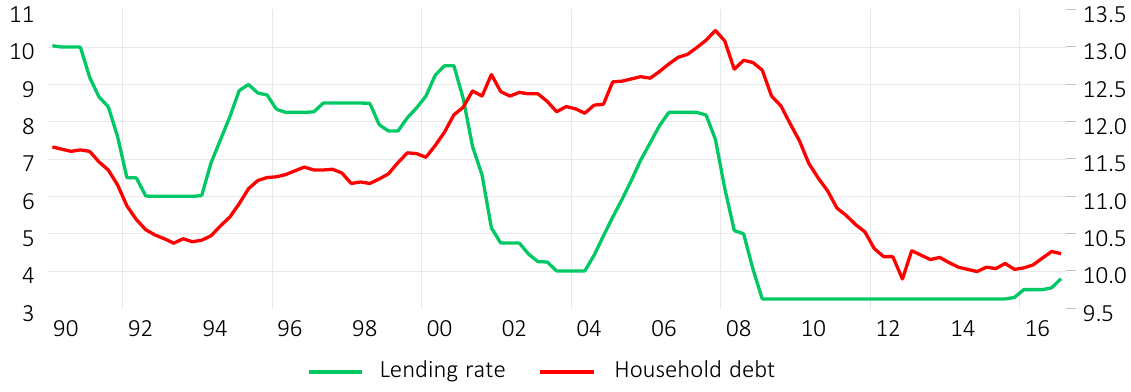
Figure 4. US lending rate vs US household